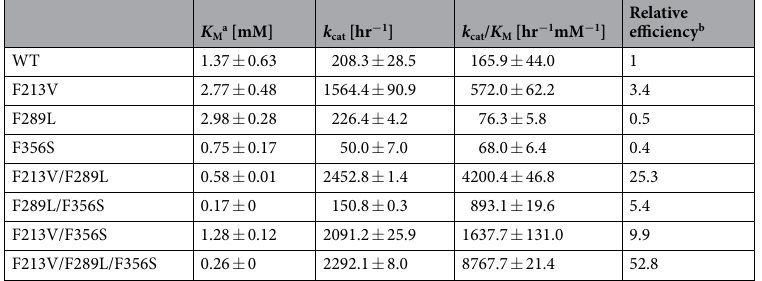
Table 1. Kinetic parameters of MDH mutant variants. a Formaldehyde as a substrate. b Relative efficiency = [ k cat / K M (mutant)]/[ k cat / K M (wild type)]. The data shown are the means and standard deviations of three independent experiments.